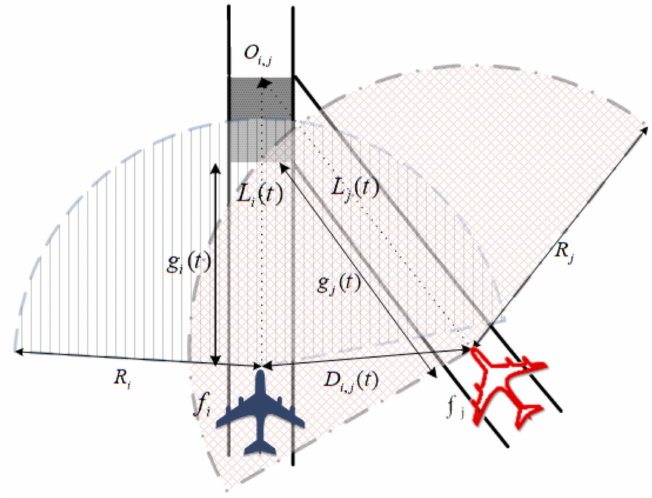
Figure 1. Rules for Visual Separation Establishment in Aircraft